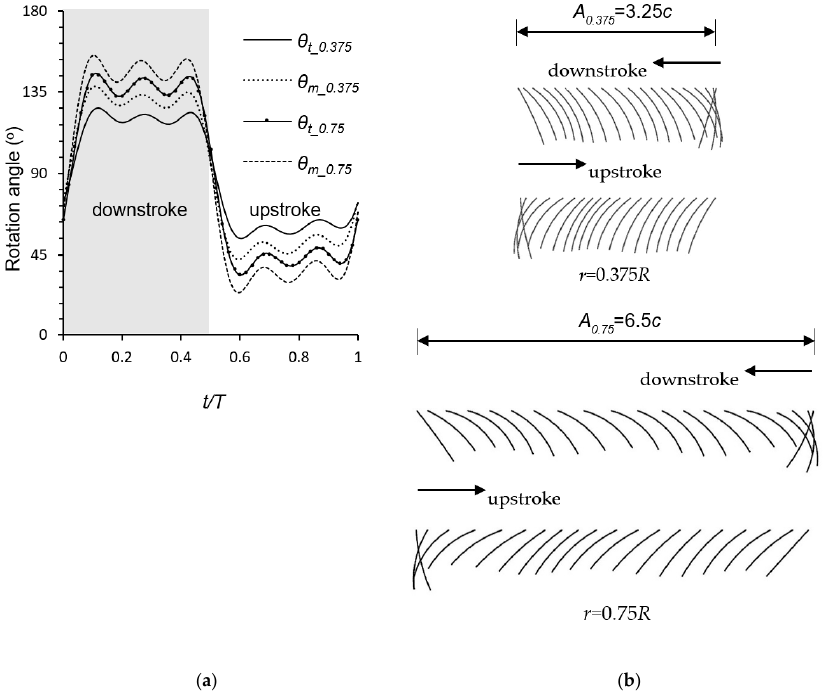
Figure 3. Extracted two-dimensional wing kinematics: ( a ) rotation angles θ t and θ m at r = (0.375 and Extracted two-dimensional wing kinematics: ( a ) rotation angles θ t and θ m 0.75) R ; ( b ) description of wing motion in upstroke and downstroke.